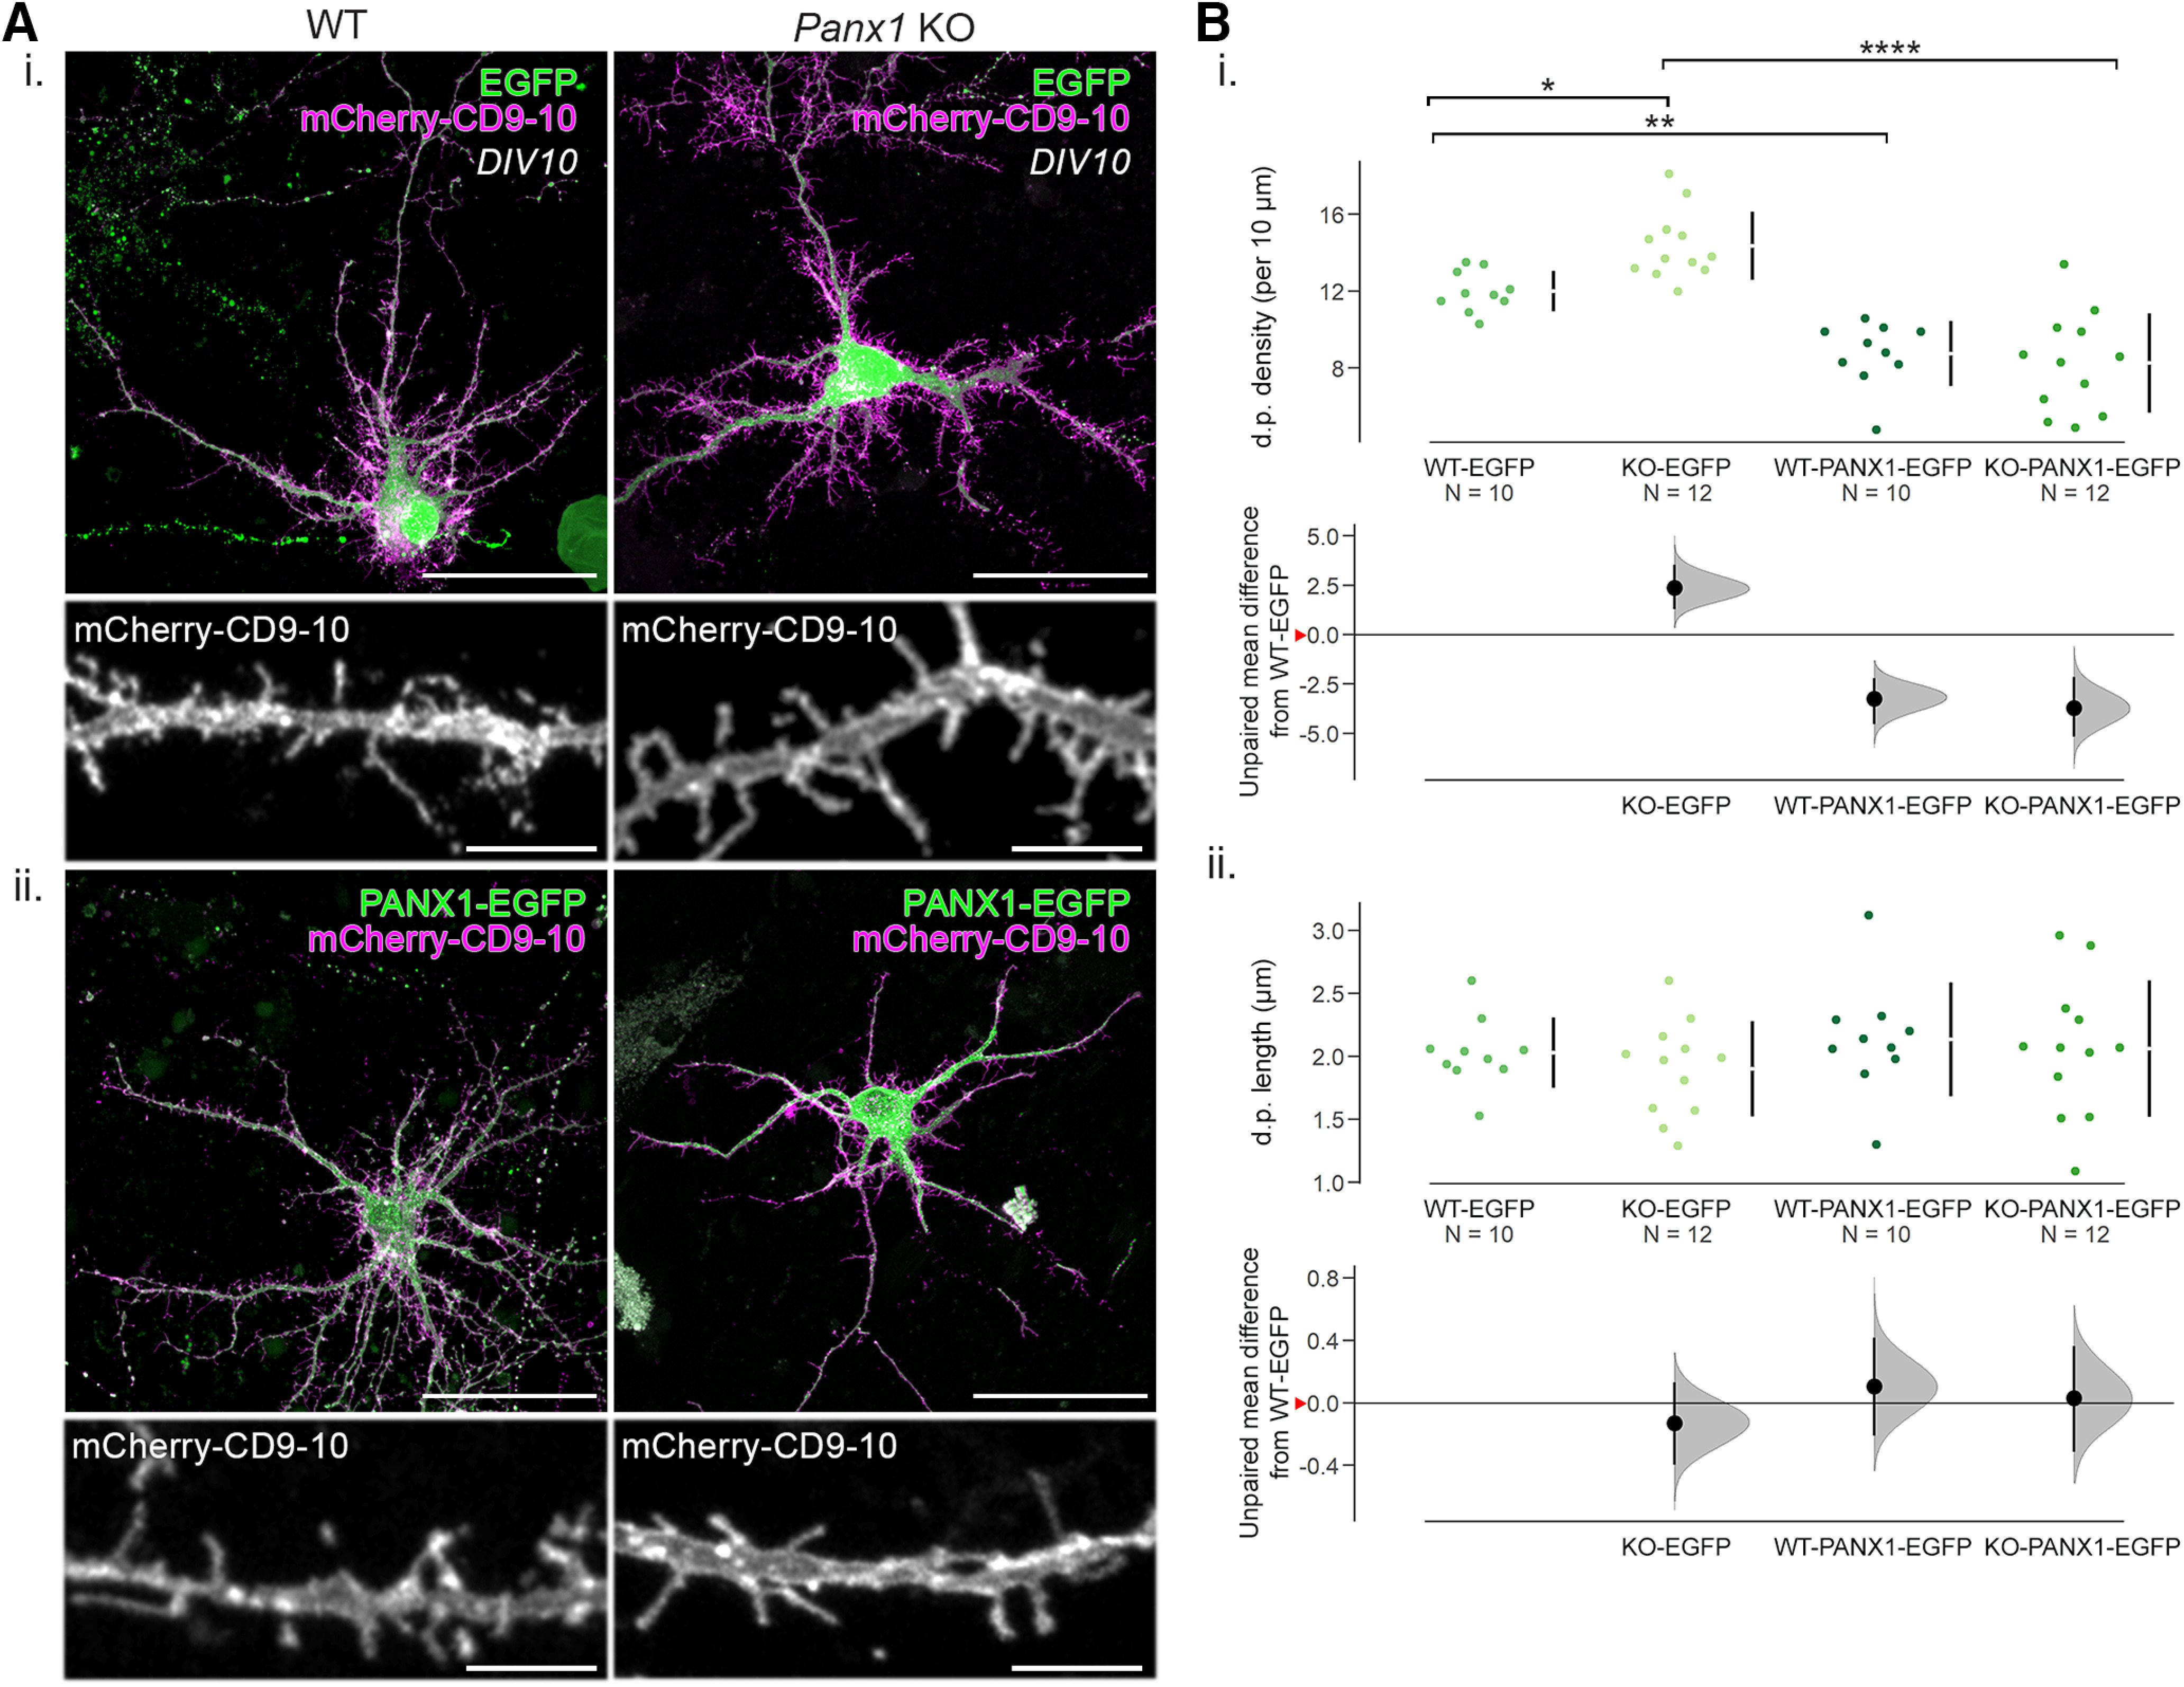
PANX1-EGFP expression rescued the increase in dendritic protrusion density associated with Panx1 KO. A, Representative maximum intensity projections of WT and Panx1 KO cultured cortical neurons transfected with mCherry-CD9-10 and either EGFP (Ai) or PANX1-EGFP (Aii) as well as cropped images of their respective dendritic segments from a primary neurite. Scale bars: 50 and 5 µm. B, Effect of PANX1 expression on dendritic protrusion density and length in developing cortical neurons transfected with mCherry-CD9-10 and either EGFP or PANX1-EGFP using Cumming estimation plots. Bi, With EGFP expression, dendritic protrusion density was higher with Panx1 KO neurons (WT-EGFP: 12.0 ± 0.3 dendritic protrusions per 10 µm; Panx1 KO-EGFP: 14.4 ± 0.5 dendritic protrusions per 10 µm, p = 0.03517, two-way ANOVA with Bonferroni’s multiple comparison testb1). With PANX1-EGFP expression, dendritic protrusion density was decreased in both WT and Panx1 KO neurons (WT-PANX1-EGFP: 8.8 ± 0.5 dendritic protrusions per 10 µm, p = 0.00268; Panx1 KO PANX1-EGFP: 8.3 ± 0.8 dendritic protrusions per 10 µm, p < 0.0001, two-way ANOVA with Bonferroni’s multiple comparison testb1). Bii, No significant differences in dendritic protrusion length were found between groups (WT-EGFP: 2.0 ± 0.3 µm; Panx1 KO-EGFP: 1.9 ± 0.4 µm, p > 0.9999, two-way ANOVA with Bonferroni’s multiple comparison testb2; WT-PANX1-EGFP: 2.1 ± 0.1 µm; Panx1 KO PANX1-EGFP: 2.1 ± 0.2 µm, p > 0.9999, two-way ANOVA with Bonferroni’s multiple comparison test). Data are presented as mean ± SD. N = cells, all analyzed cells were obtained from three independent cultures. Effect sizes are reported in the main text and Table 2. Red arrowheads on the y-axis on the bottom panel of Cumming estimation plots represent WT-EGFP means. d.p., dendritic protrusion; ****<0.0001, **<0.01, *<0.05. This figure was modified from the PhD Thesis of J.C.S.-A, University of Victoria (Sanchez-Arias, 2020), found at http://hdl.handle.net/1828/11714.